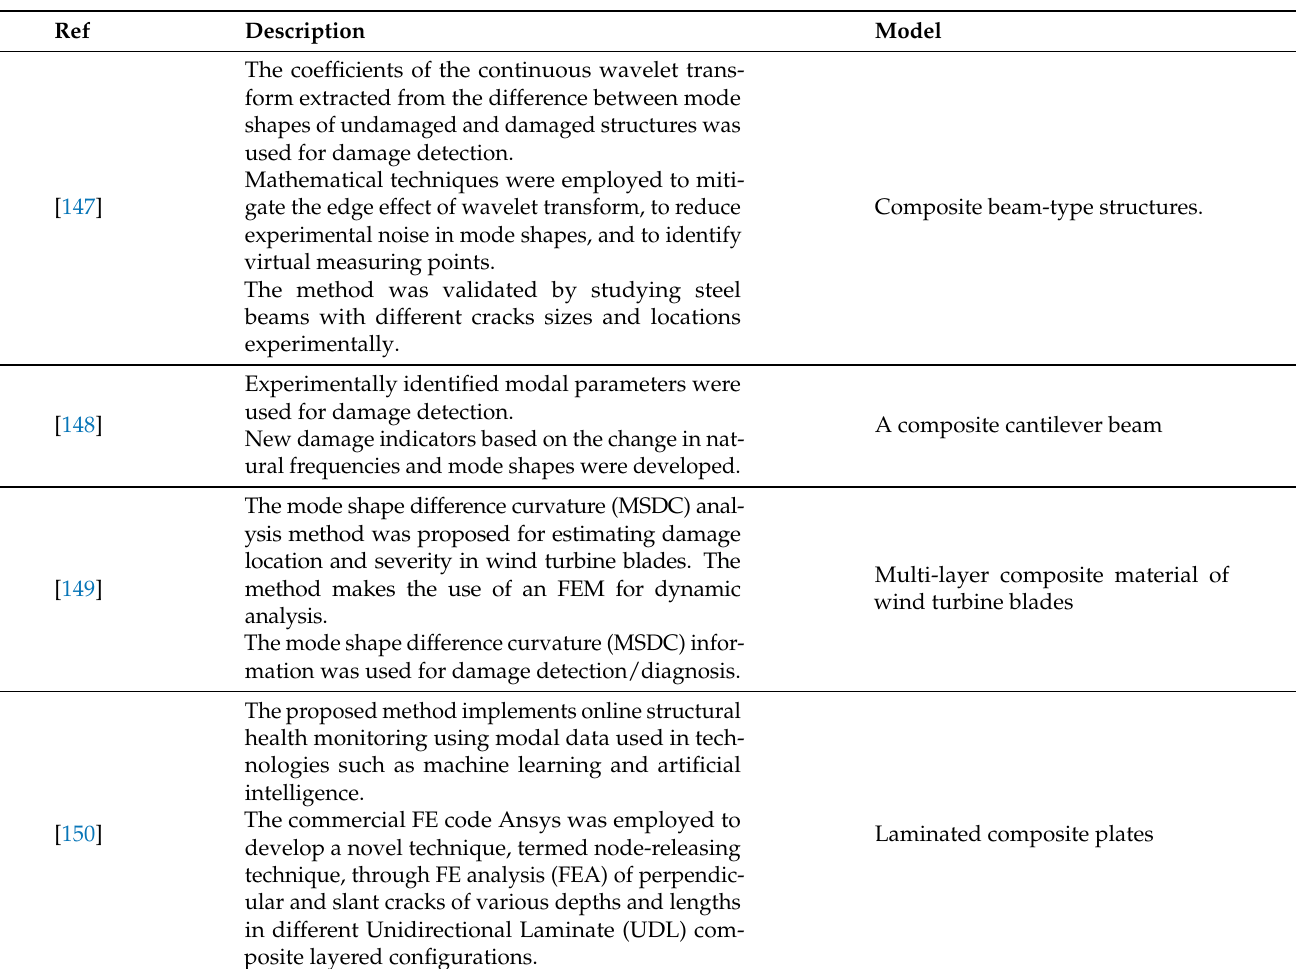
Table 10. Some methods developed for damage detection in composite structures using mode